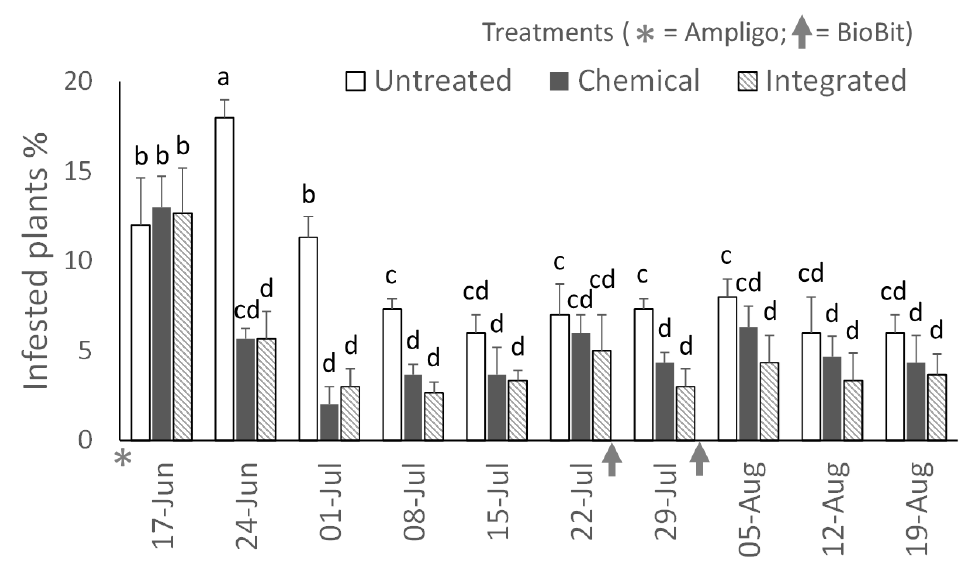
Figure 5. Dynamics of O. nubilalis larval density (mean ± SD) observed from outside on treated (chemical and integrated) and untreated plants over the whole experimental period. Different letters above bars indicate significant differences among means (ANOVA Mixed Proc., p < 0.05).